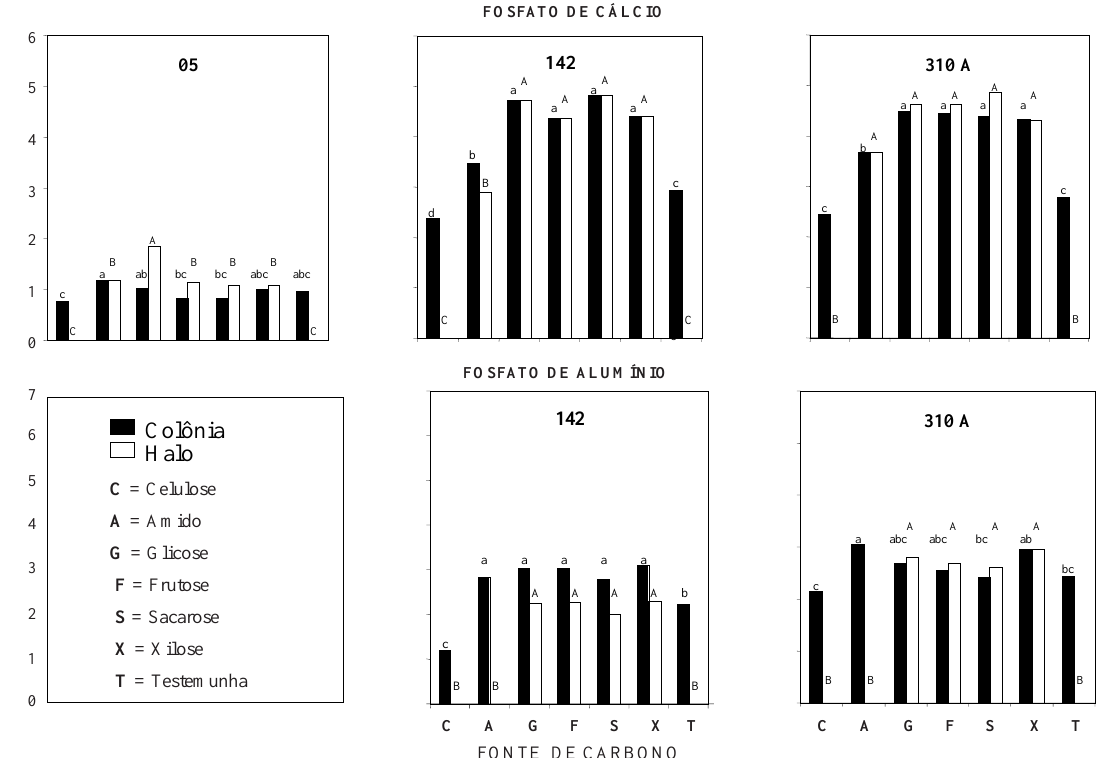
Figura 3. Efeito de fontes de carbono no crescimento e na capacidade de solubilizar fosfato de cálcio e alumínio dos isolados 05, 142 e 310 A. Letras minúsculas e maiúscula comparam em cada isolado e fosfato o diâmetro de colônia e da área solubilizada, respectivamente, pelo teste de Tukey a